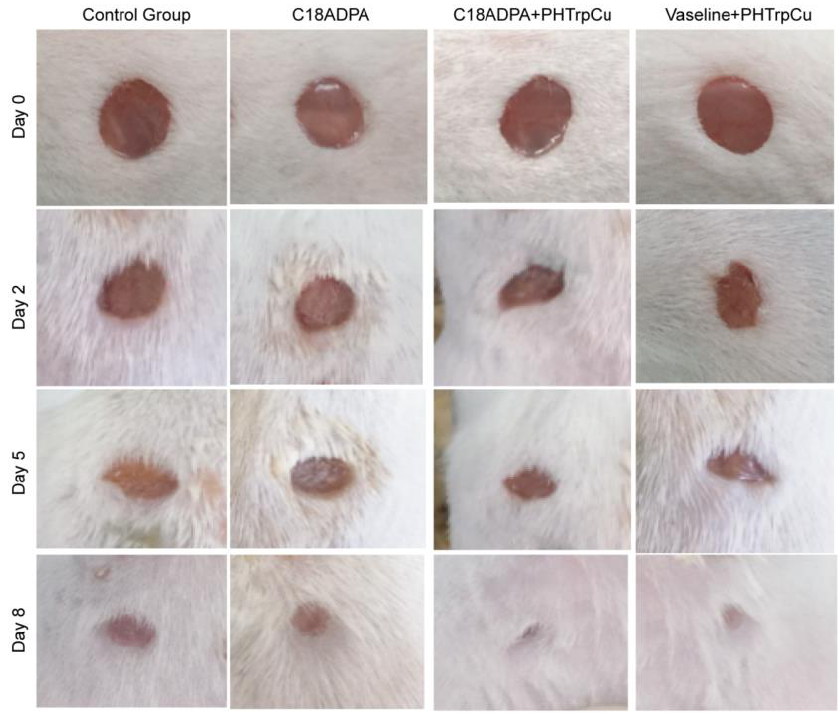
Figure 8. The process of wound healing. The diameter of the wound area was 5 mm on day 0. Pictures were taken on day 0, 2, 5, and 8 for the different groups, and there were six mice in each group. The wound healing was evaluated by the percentage of wound closure [30].